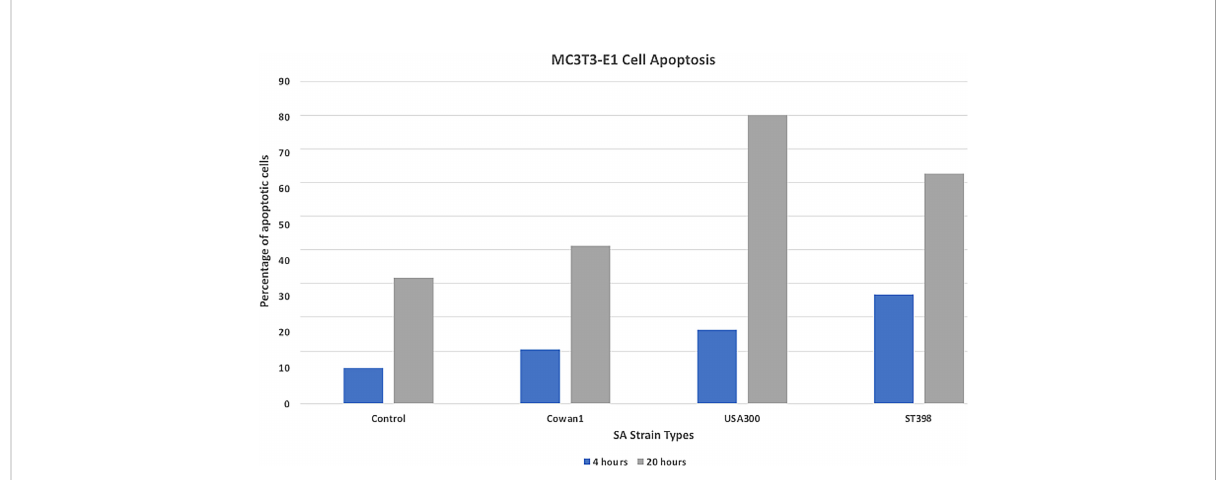
FIGURE 1 Apoptosis assay. Flow cytometry annexin staining for early (4hr) and late (20hr) apoptosis. USA300 appeared to induce a stronger apoptotic affect compared with ST398 strain UTCVM1. Cells infected with Cowan1 underwent apoptosis to a lesser extent. Uninfected cells served as the